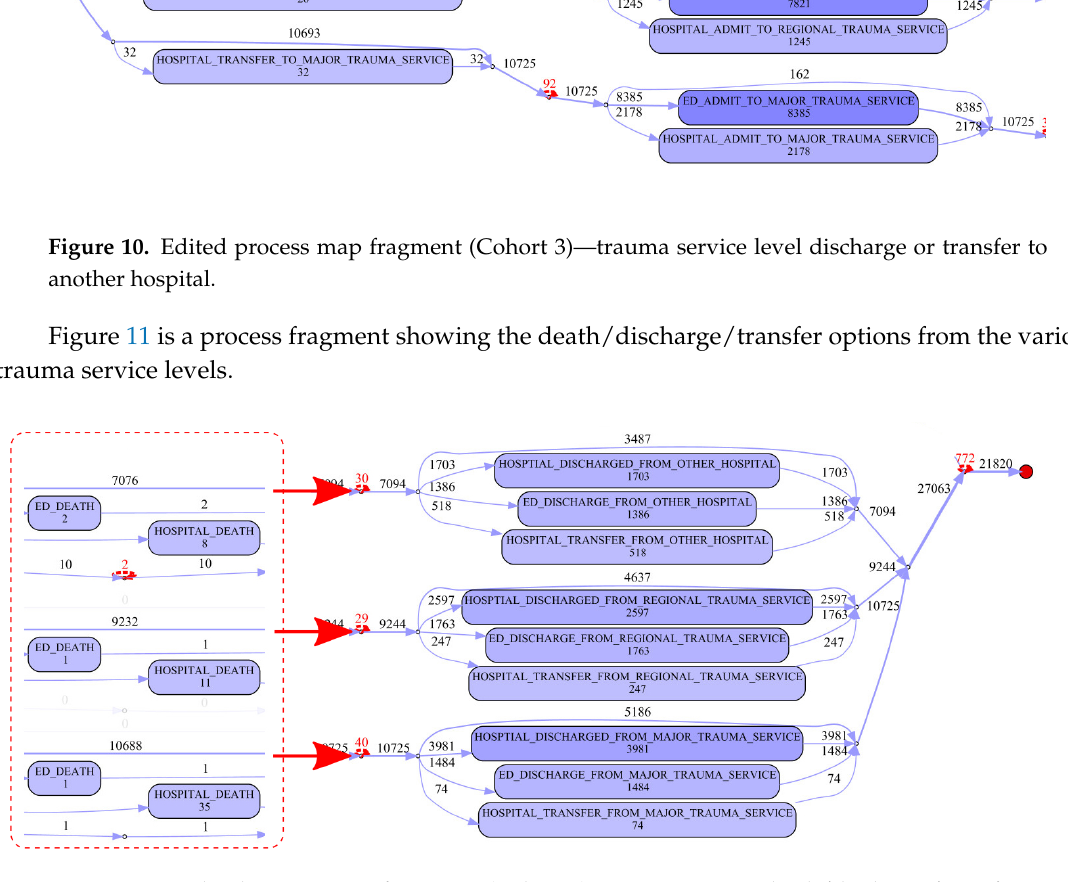
Figure 11. Edited process map fragments (Cohort 3)—trauma service